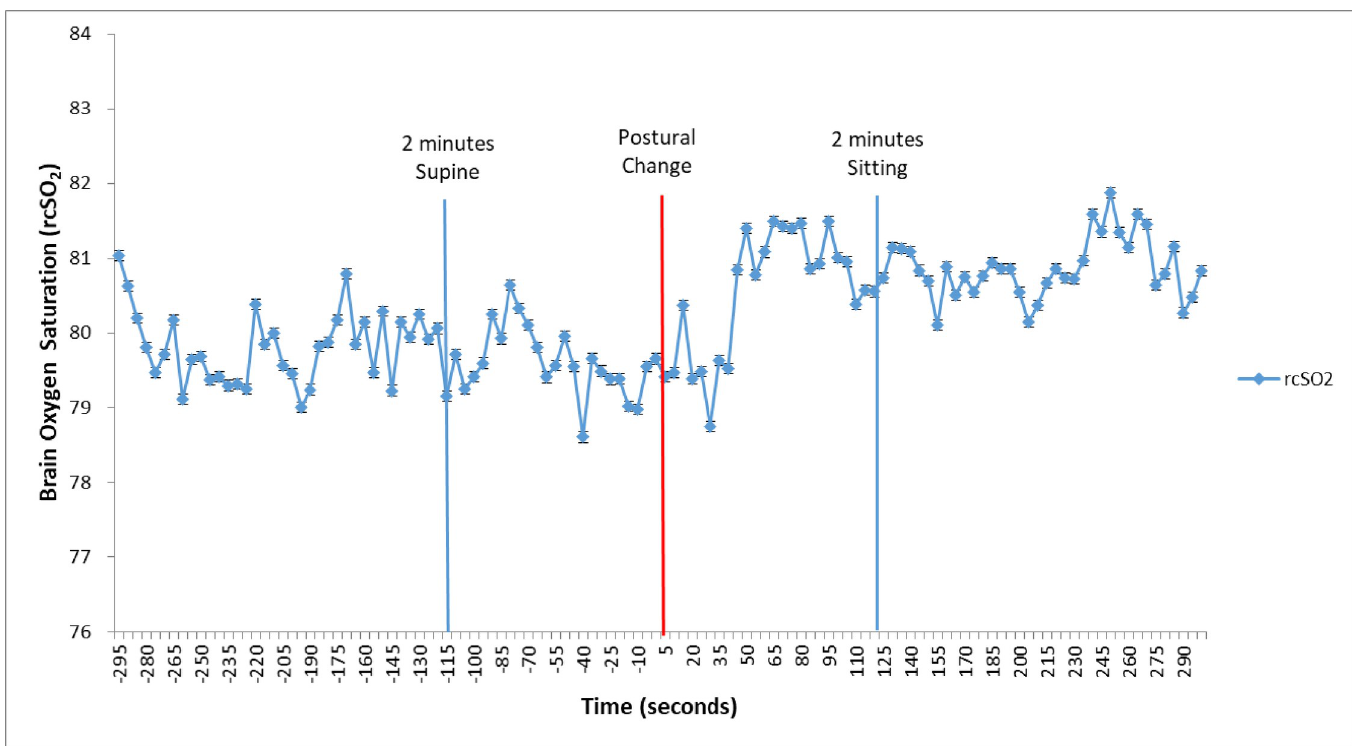
Fig 1. Example of a rcSO 2 time series. We show the mean rcSO 2 time series for the healthy control infants. Measures were collected every 5 seconds for 5 minutes in each posture. Visually examining all individual time series provided the basis for selecting values 2 minutes before and after the postural change for our cerebrovascular stability analysis. We aimed to capture posture-induced changes, but eliminate the eventual return to baseline after the change.